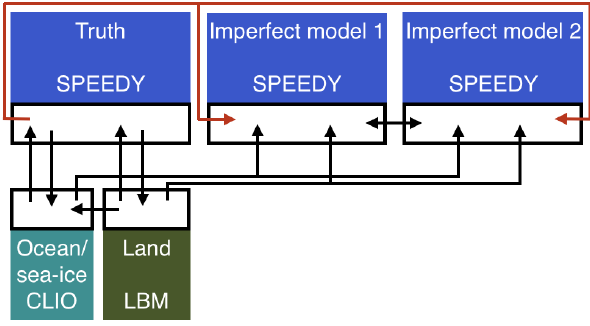
Figure 6. Schematic representation of the SPEEDO system during training (Selten et al.,